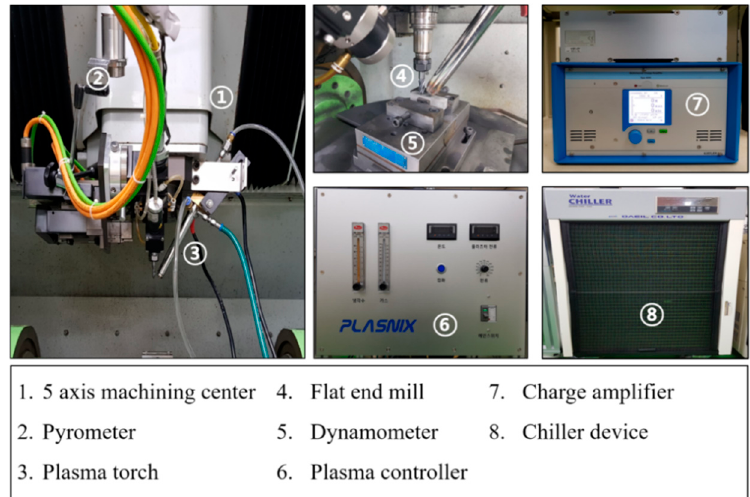
Figure 6. Experimental setup.